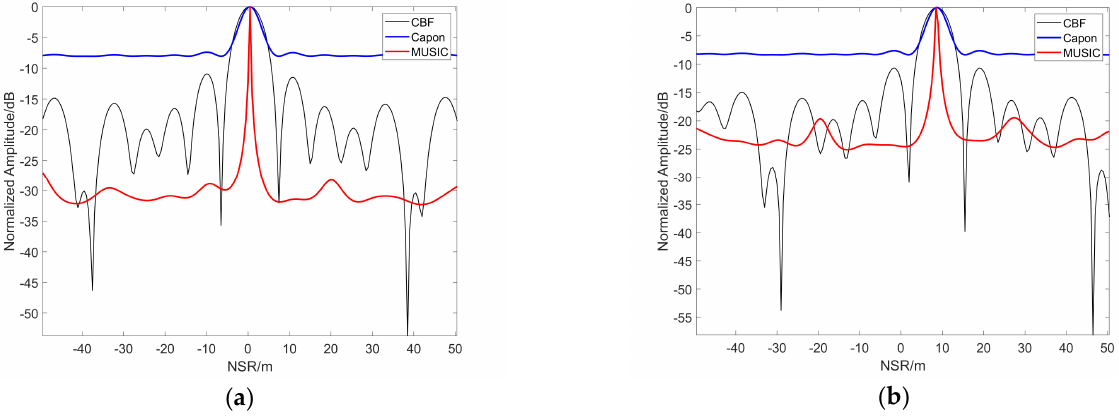
Figure 16. GCP point results with baseline number 10: ( a ) 1st point; ( b ) 55th point.